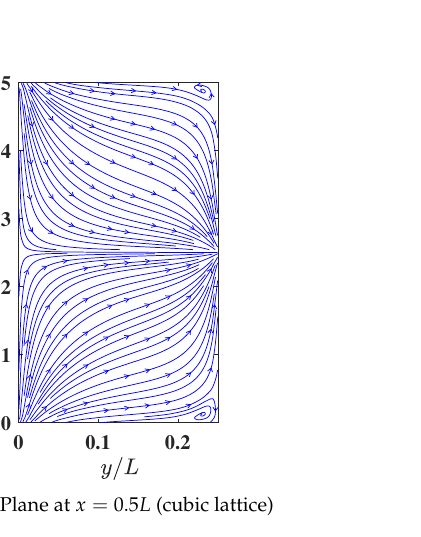
Figure 11. Comparison of streamline patterns along the mid-planes of a 3D shallow lid driven cavity of aspect ratio L / H = 2 and L / W = 4 at a Reynolds number Re = 100 computed using 3DCCM-LBM with the cubic lattice ( ( r , s ) = ( 1.0,1.0 ) ) using a grid resolution of 256 × 128 × 64 shown in sub-figures ( a , c , e ) and compared with the 3DCCM-LBM with the cuboid lattice ( ( r , s ) = ( 0.406,1.3 ) ) using a grid resolution of 104 × 64 × 40 shown in sub-figures ( b , d , f